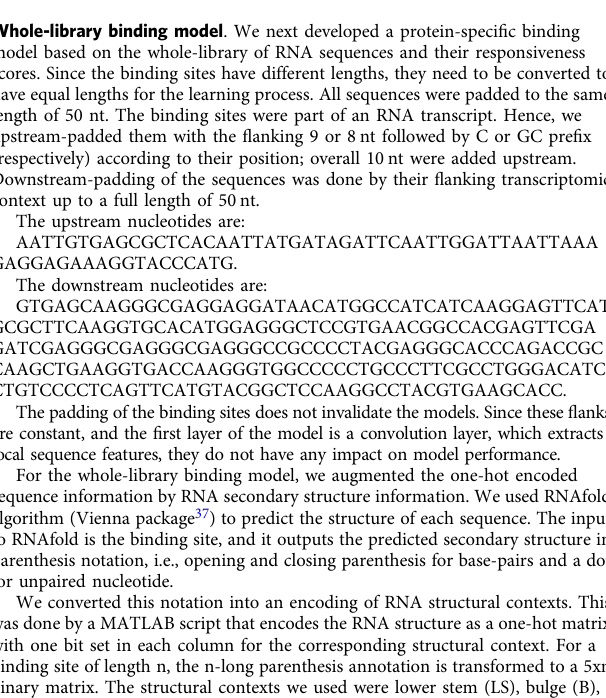
(Left) The search space for the hyper-parameters search. (Right) The hyper-parameters of the fi nal